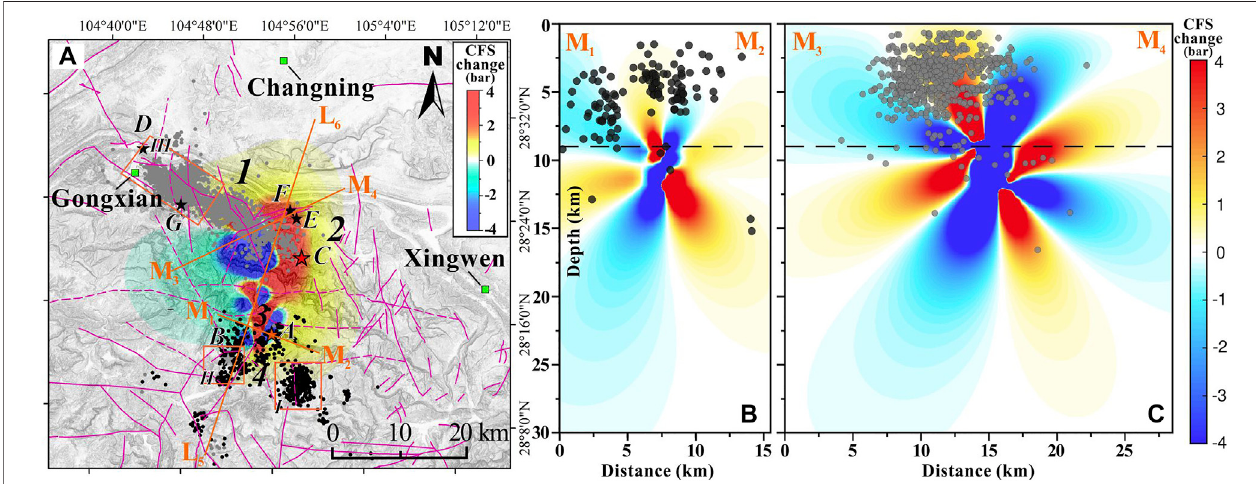
FIGURE5 | Coulomb failurestress (CFS) changes in the study area. (A) CFS change at adepth of 9 km. (B,C) CFS changes on Pro fi les M 1 – M 2 and M 3 – M 4, which are labeled in (A) . Stars denote the epicenters of the Ms > 5 aftershocks. Dark and grey dots represent the epicenters of the Ms > 1 aftershocks of the Xingwen and Changning earthquakes, respectively. The cross-section of Pro fi le L 5 – L 6 is presented in Figure 7 .